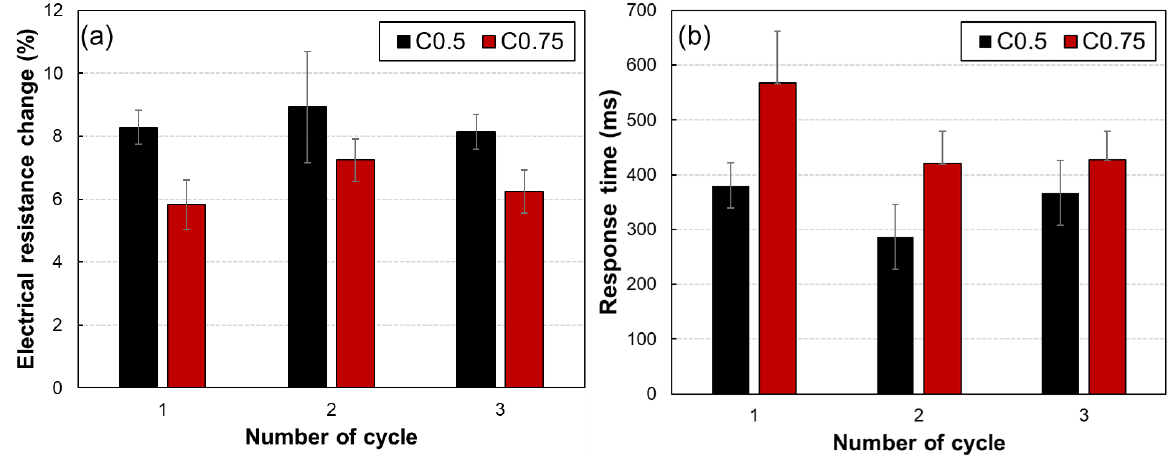
Figure 6. ( a ) Magneto-sensing sensitivity and ( b ) response time of C0.5 and 0.75 samples.